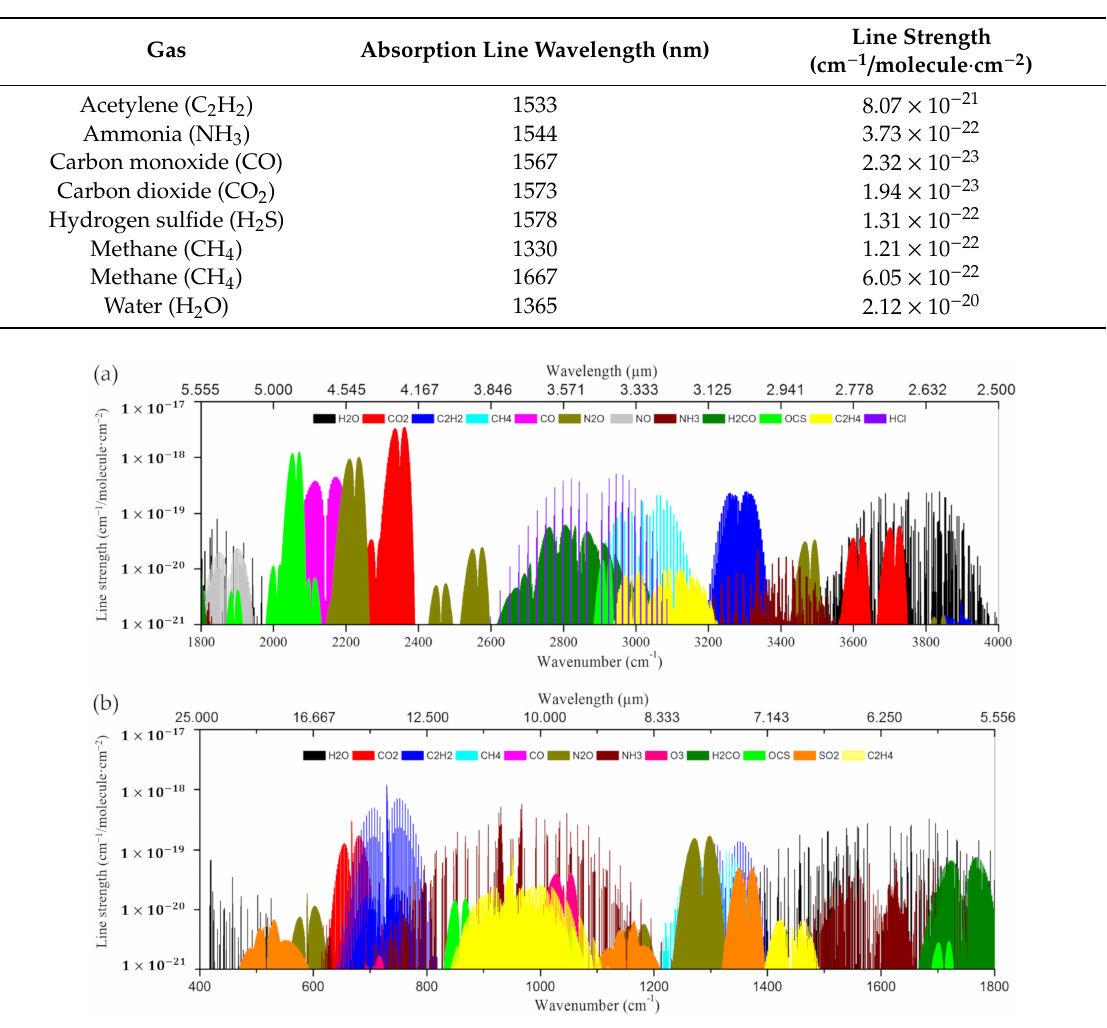
Figure 2. Mid-infrared (MIR) absorption spectroscopy for major atmospheric species in the wavelength range of ( a ) 2.5–5.555 µ m and ( b ) 5.556–25 µ m